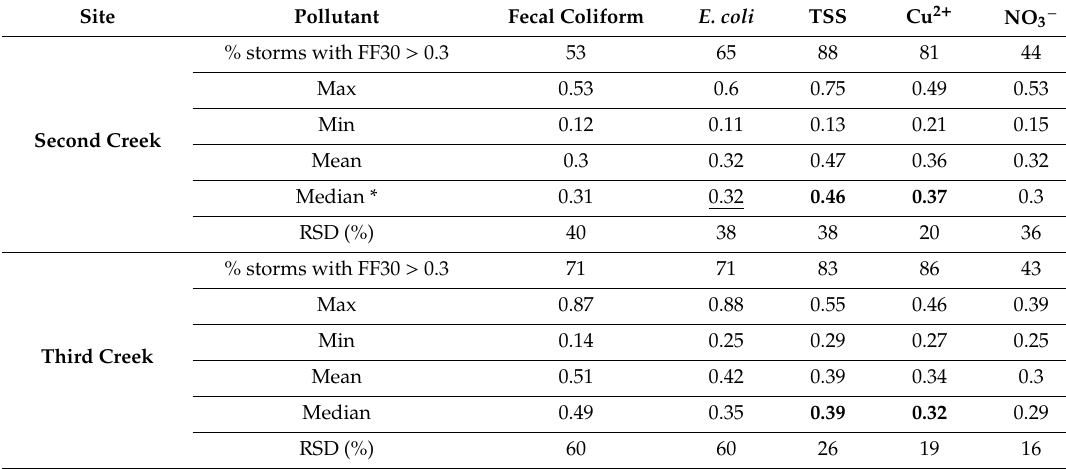
Table 2. Summary statistics of FF 30 : maximum, minimum, mean, median, and RSD for fecal coliform, E. coli , TSS, Cu 2 + , and NO 3 −